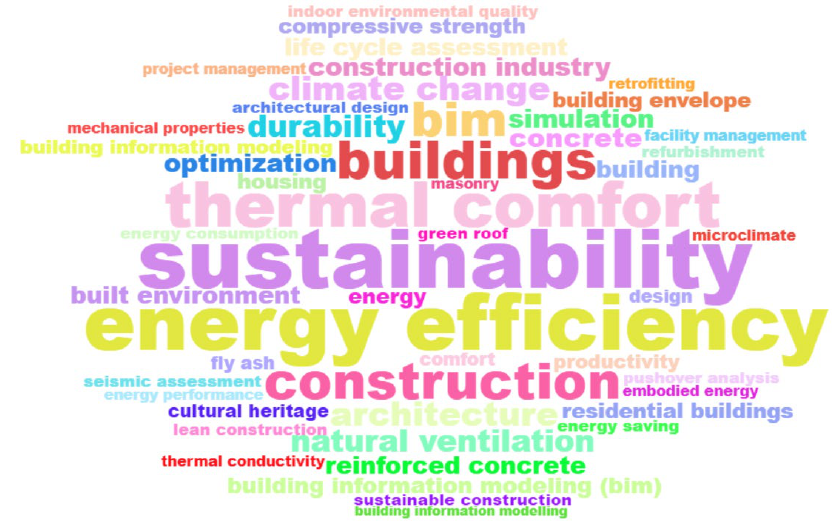
Figure 3. Word cloud of keywords.